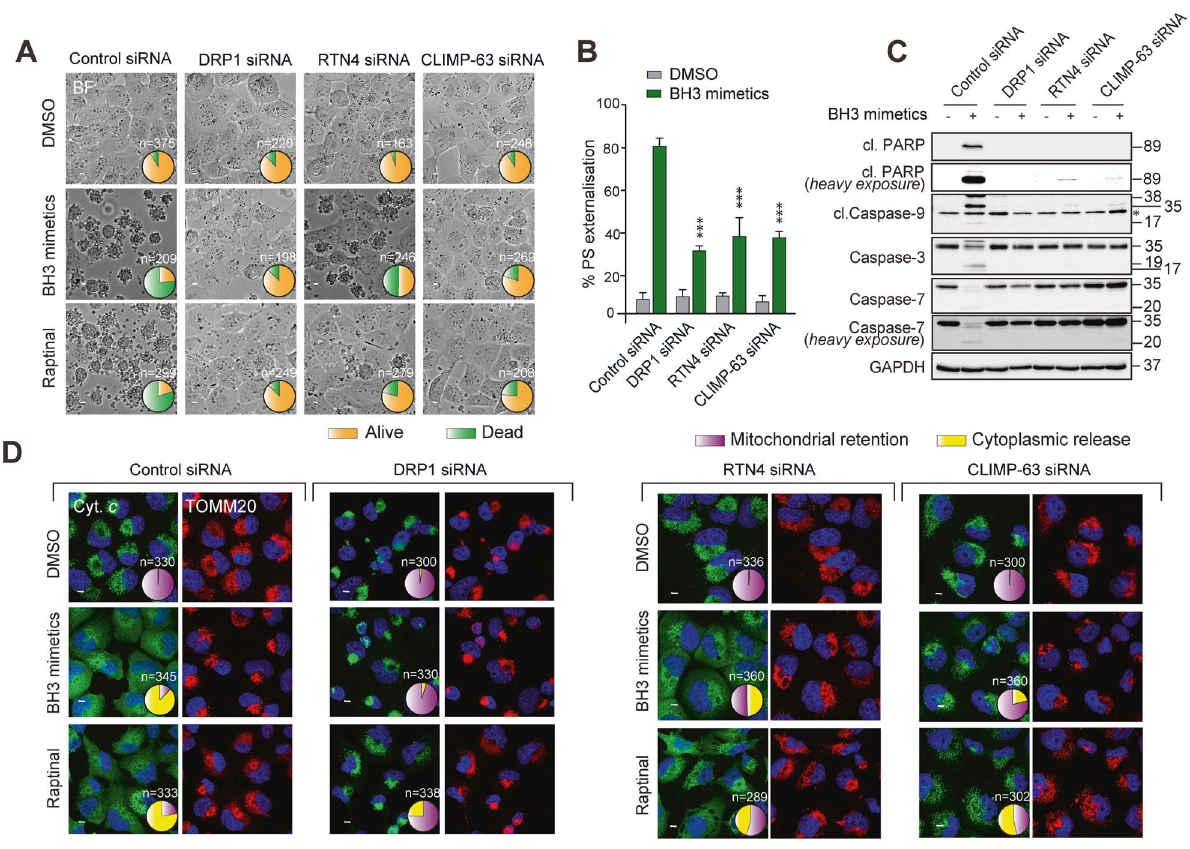
Fig. 6 ER shaping proteins differentially regulate MOMP and apoptosis in a stimulus-speci fi c manner. A H1299 cells, transfected with control, DRP1, RTN4 or CLIMP-63 siRNA for 72 h, were exposed to a combination of BH3 mimetics, A-1331852 (0.1 μ M) and A-1210477 (10 μ M), or Raptinal (10 μ M) for 4 h. Bright fi eld images show live versus dead cells, which were counted in the speci fi ed numbers of cells ( n ) across 3 independent experiments and are presented as pie charts here, and as bar graphs in Supplementary Fig. 13. B Cells from ( A) were stained with Annexin-V and PI and the extent of phosphatidylserine (PS) externalisation measured via fl ow cytometry. Data shown are mean ± SEM, from at least 3 independent experiments. *** p ⩽ 0.001 (ordinary one-way ANOVAs with Dunnett ’ s multiple comparisons tests; F(318) = 19.84, p < 0.0001). C Cells from ( A) were lysed and immunoblotted for the indicated antibodies. The abbreviation cl denotes ‘ cleaved ’ and * in the cleaved caspase 9 blot denotes a non-speci fi c band. D H1299 cells transfected with the indicated siRNAs for 72 h, were exposed to